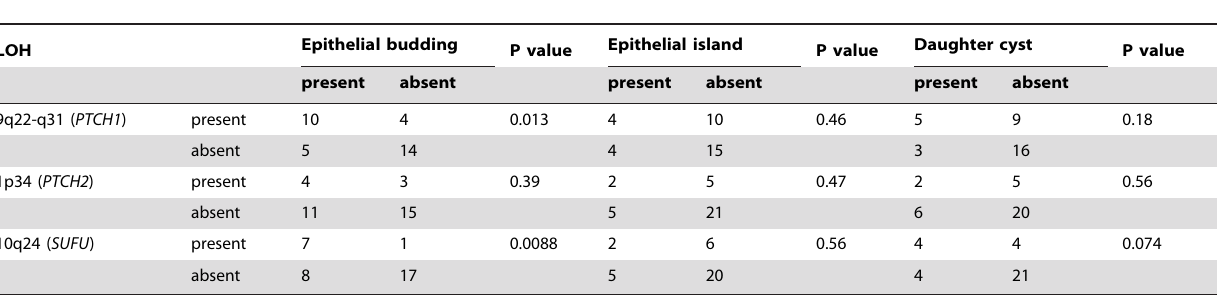
Table 2. Correlation between the presence of each LOH and the histological parameters.